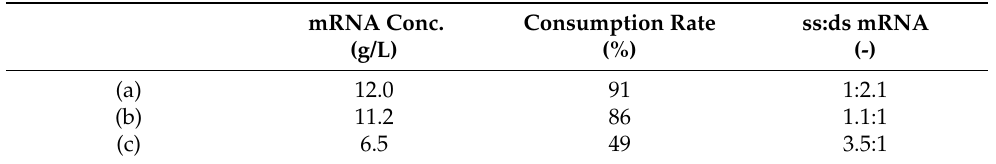
Table 9. Comparison of mRNA concentration, consumption rate, and ss:ds mRNA ratio of batch ( a ) reaction and reproduction in PFR with ( c ) and without ( b ) urea as additive. mRNA Conc.